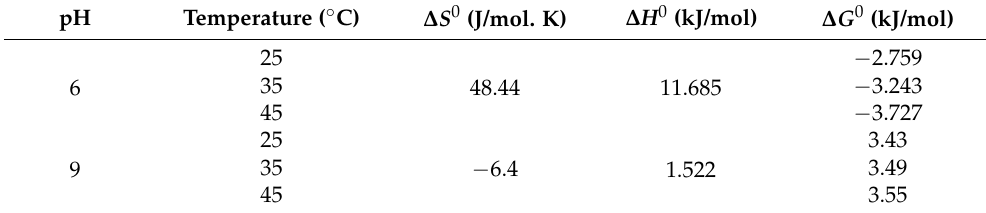
Table 6. Gibbs free energy, entropy, and enthalpy of the adsorption process of Mo onto CDC at various temperatures and pH 6 and 9; CDC loading: 0.6 g/L; agitation speed: 150 RPM. pH Temperature ( ◦ C) ∆ S 0 (J/mol. K) ∆ H 0